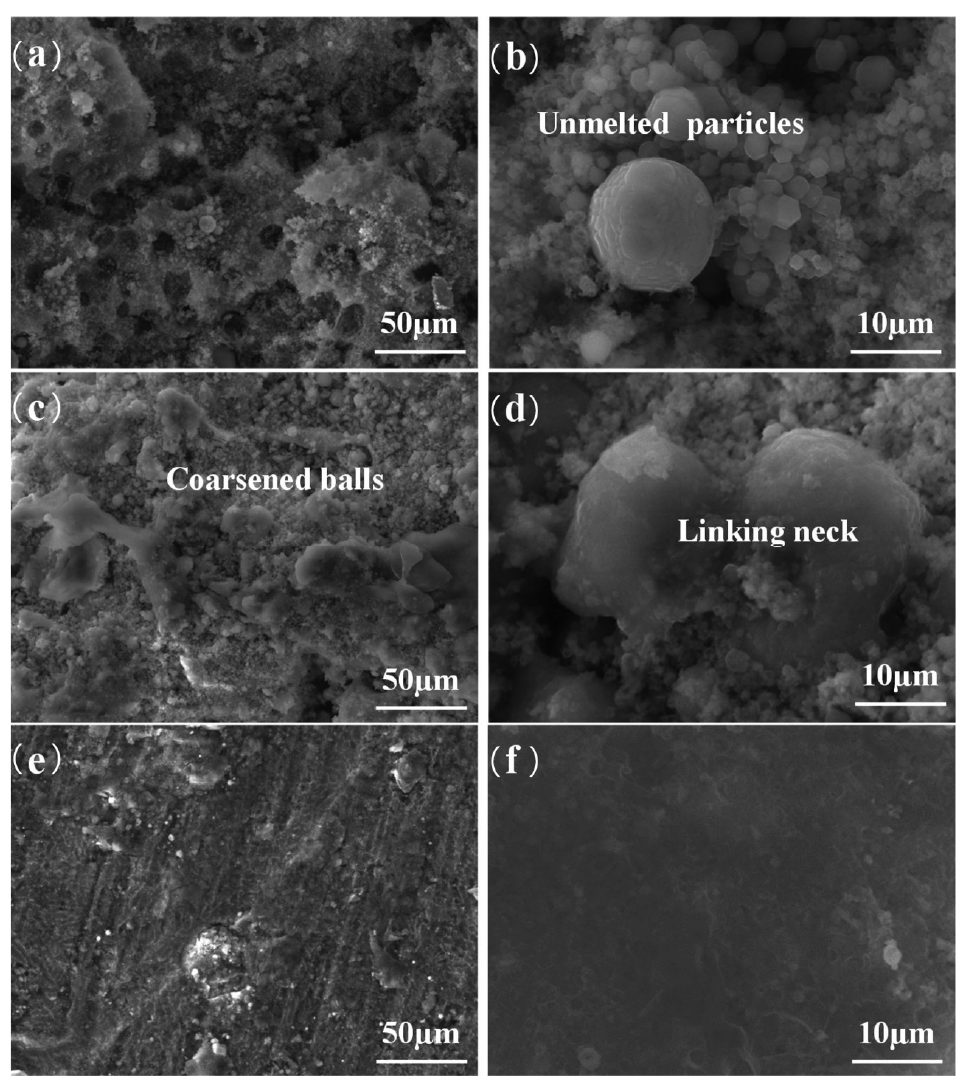
Figure 5. Surface of SLM tracks at various laser energy density: ( a ) 2.0 J/mm, ( c ) 5.0 J/mm, ( e ) 10.0 J/mm, ( b , d , f ) are high resolution of ( a , c , e ), respectively. Reprinted with permission from ref. [48]. Copyright 2016 Taylor and Francis Group.